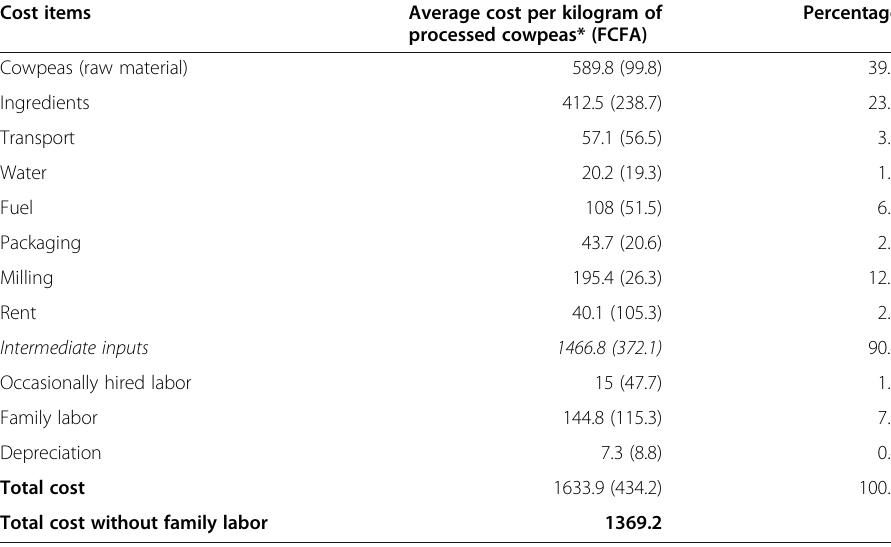
Table 4 Production costs of atta made from white cowpeas Cost